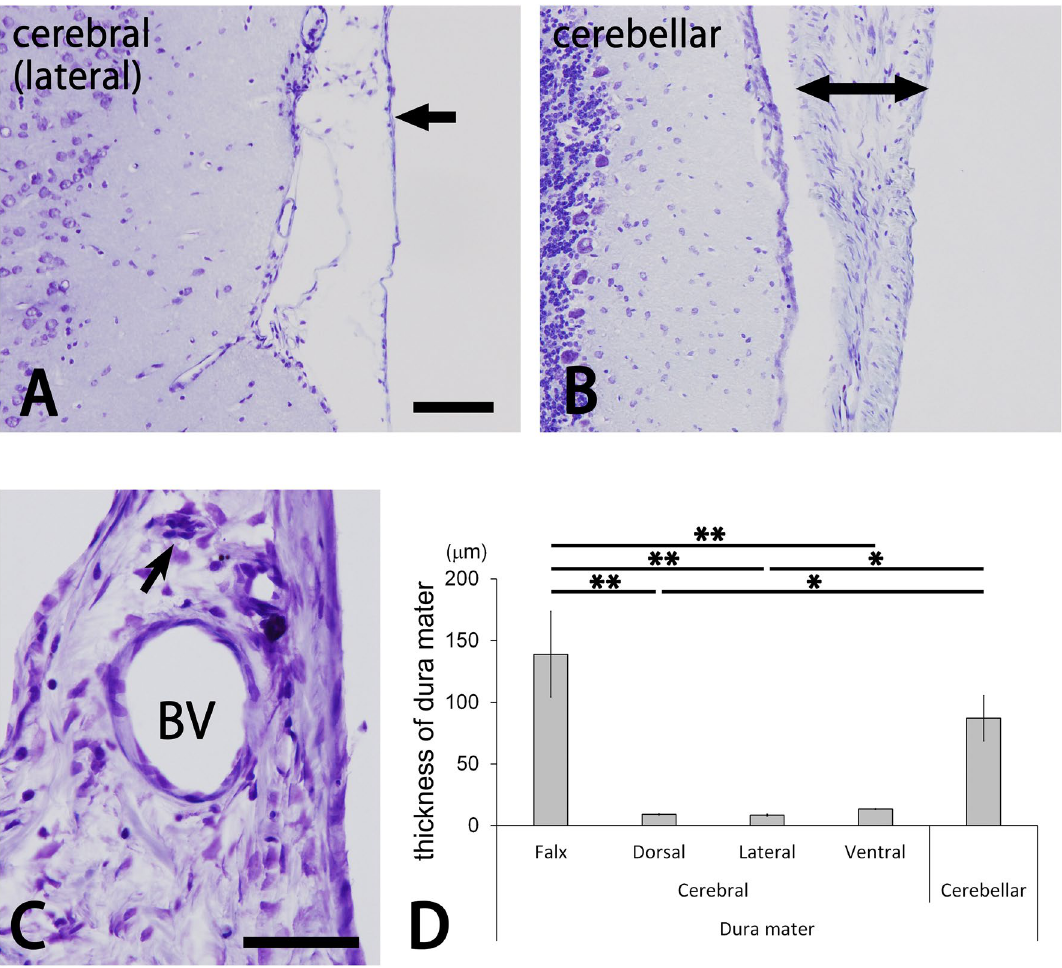
Figure 1. Photomicrographs for cresyl violet-stained cerebral and cerebellar dura mater ( A – C ). The lateral portion of the cerebral dura mater is thin (arrow in A ), whereas the cerebellar dura mater is very thick (right and left arrows in B ). The thick dura mater ( C ) contains a large blood vessel (BV) and nerve bundle (arrow). Bars = 100 µm (A) and 50 µm (C). Panels ( A ) and ( B ) are at the same magnification. Bar graphs indicate the thickness of the cerebral and cerebellar dura mater ( D ). The cerebral falx and cerebellar dura mater were significantly thicker than other portions of the cerebral dura mater (Tukey’s test *p < 0.05; **p < 0.01). Data were obtained from three sections of the cerebral falx; three to six sections of the dorsal, lateral and ventral portions of the cerebral dura mater; and two sections of the cerebellar dura mater in each of the four